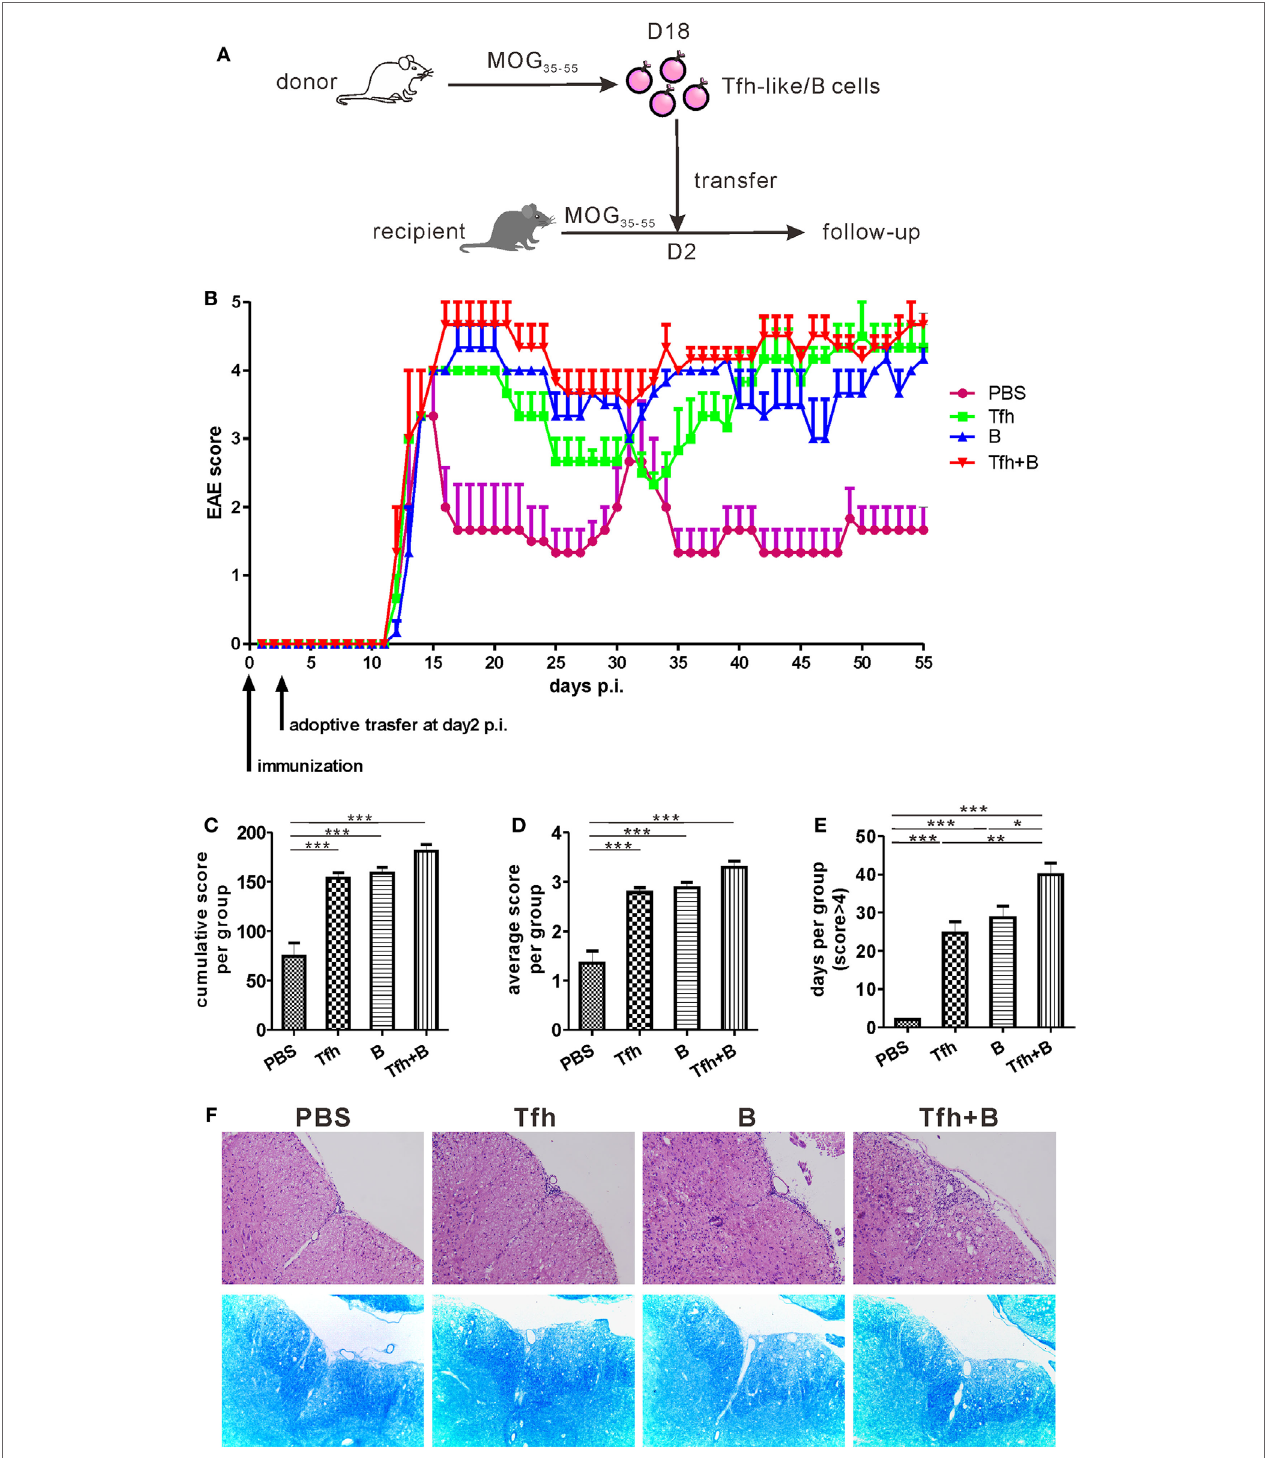
FigUre 6 | Adoptive transfer of T follicular helper (Tfh) or B cells delayed remission of MOG 35–55 -induced experimental autoimmune encephalomyelitis (EAE). (a) The process diagram of adoptive transfer experiments. Briefly, CD4 + CXCR5 + Tfh-like cells and CD19 + B cells were, respectively, sorted from the spleens of MOG 35–55 - immunized mice (donor) at 18 dpi. Isolated CD4 + CXCR5 + T cells and/or CD19 + B cells were then transferred into pre-immunized mice (recipient) at 2 dpi. (B) The EAE score were measured in the following 55 days after antigenic challenge ( n = 3 mice/group). (c) Cumulative score of each mouse in the 55 days. (D) Average score of each mouse in the 55 days. (e) The number of days for each mouse to score more than 4. All data were shown as mean ± SEM. * P < 0.05, ** P < 0.01, *** P < 0.001. (F) H&E and LFB staining for the spinal cords of the adoptive transferred mice.